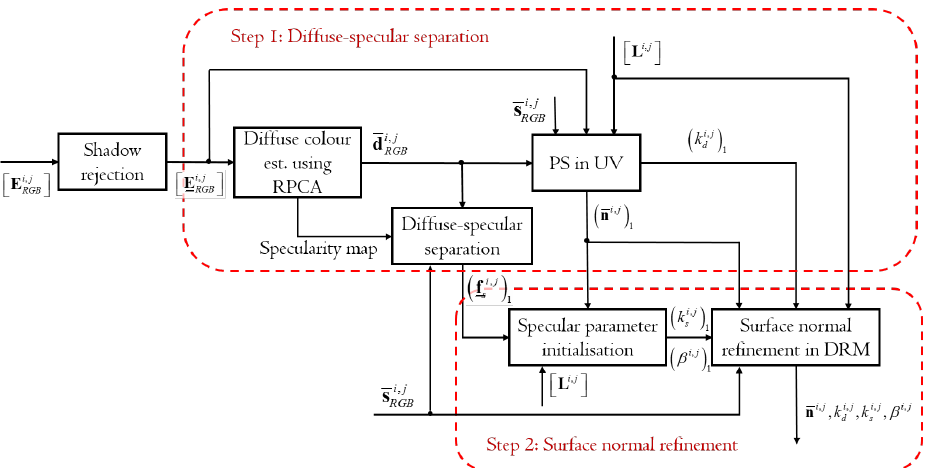
Figure 3. Flows and the original contribution of the DRM-based colour